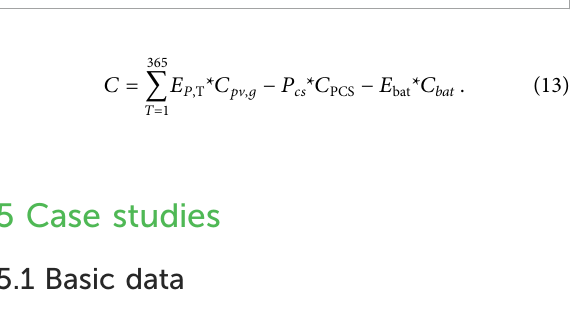
FIGURE 4 Monthly solar curtailment power and solar curtailment rate.